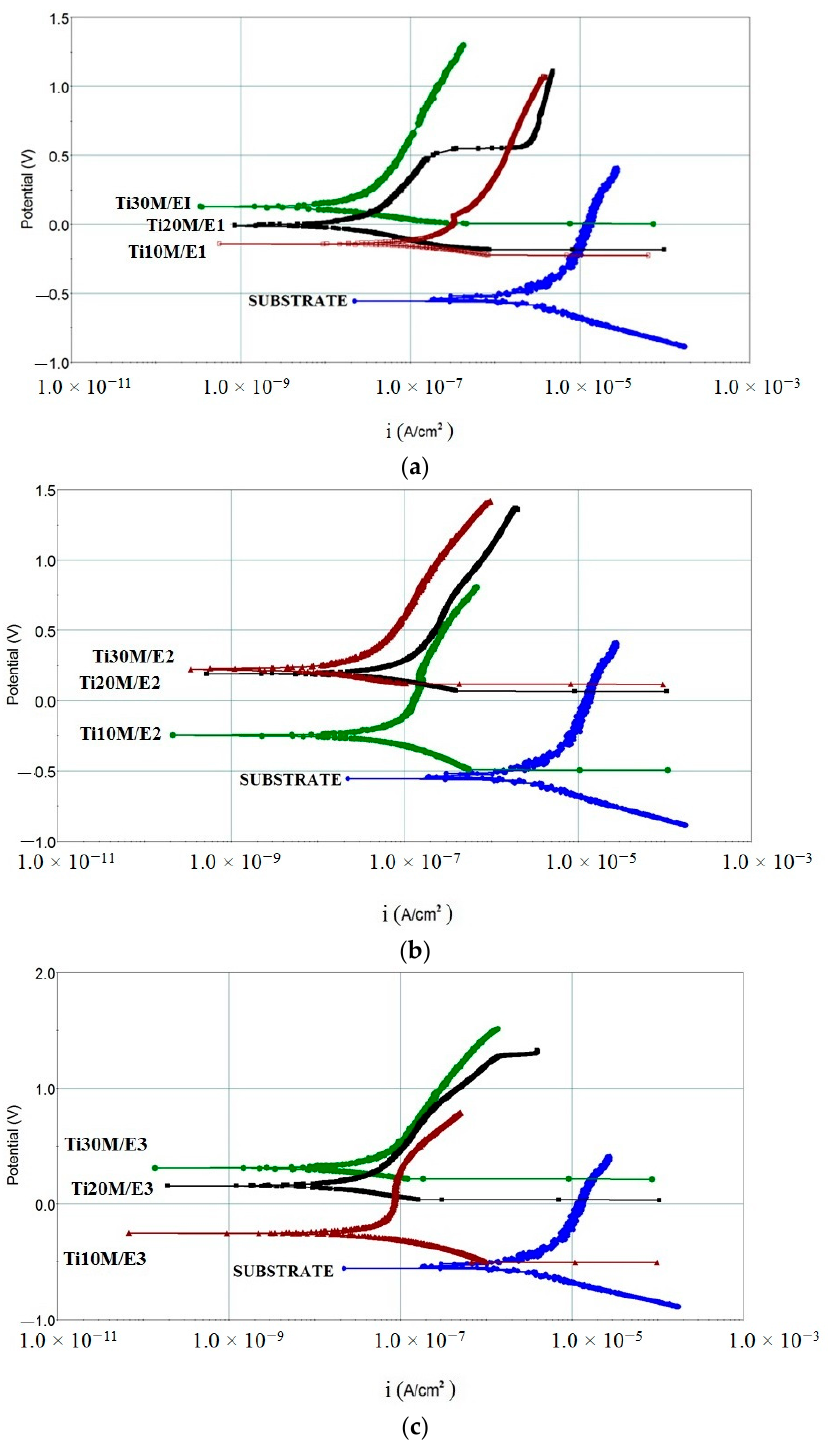
Figure 9. Potentiodynamic polarization curves of Cp-Ti substrate and PEO coatings formed after 10, 20 and 30 min PEO process time in: ( a ) E1; ( b ) E2; ( c ) E3 electrolyte.